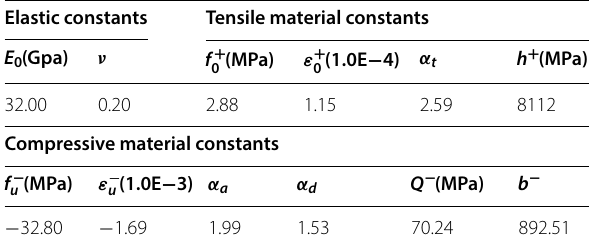
constants used for the biaxial compressive